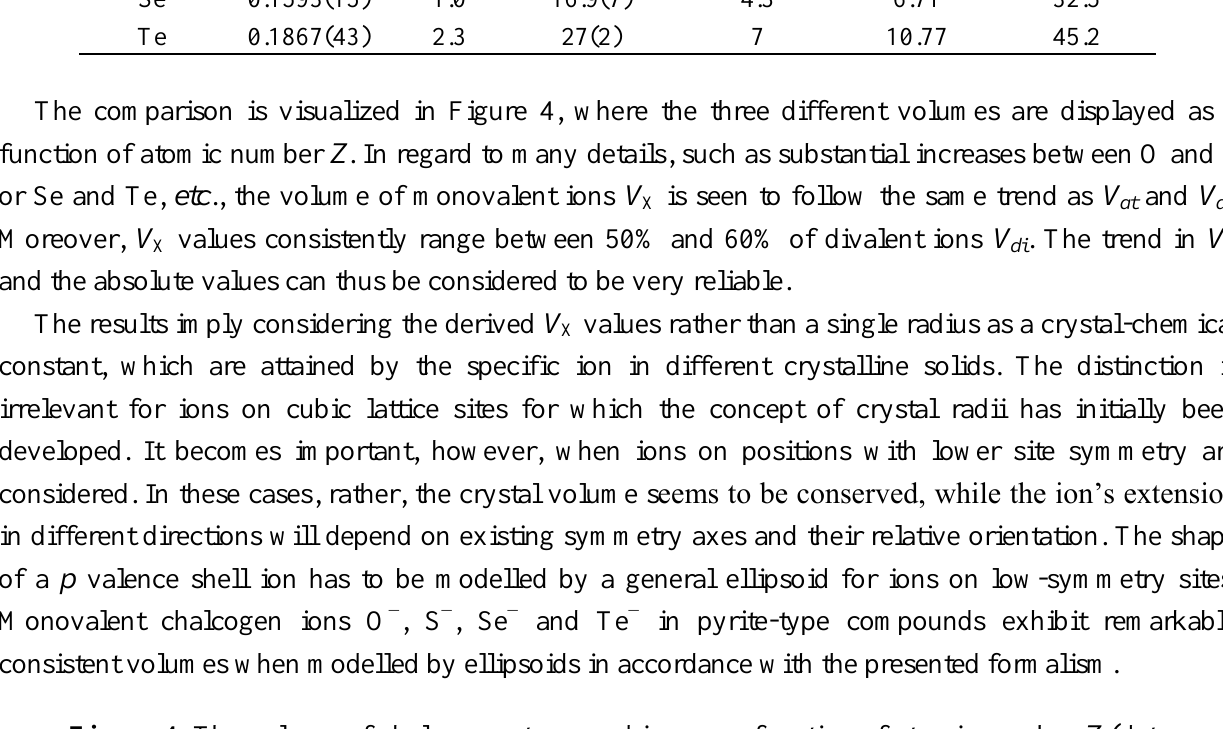
Figure 4. The volume of chalcogen atoms and ions as a function of atomic number Z (data are given in Table 2). In the plot, V stands for the volume of covalent atoms (from [39], at MW), V for monovalent ions as derived in this work and V for divalent ions (from [7,8], X di SPS). Continuous and dashed lines merely serve as a visual